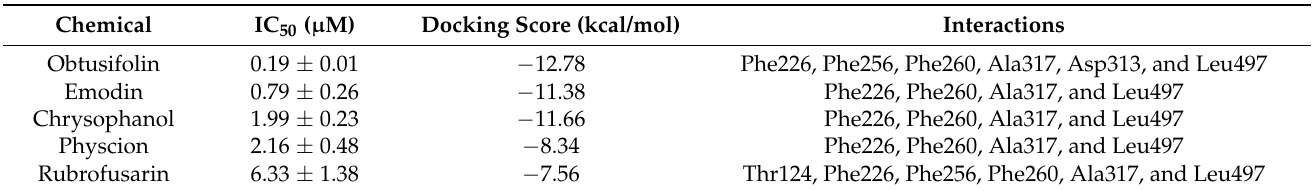
Table 2. Interactions and binding energy of four anthraquinones (obtusifolin, emodin, chrysophanol, and physcion) and one naphthopyrone (rubrofusarin) with CYP1A2